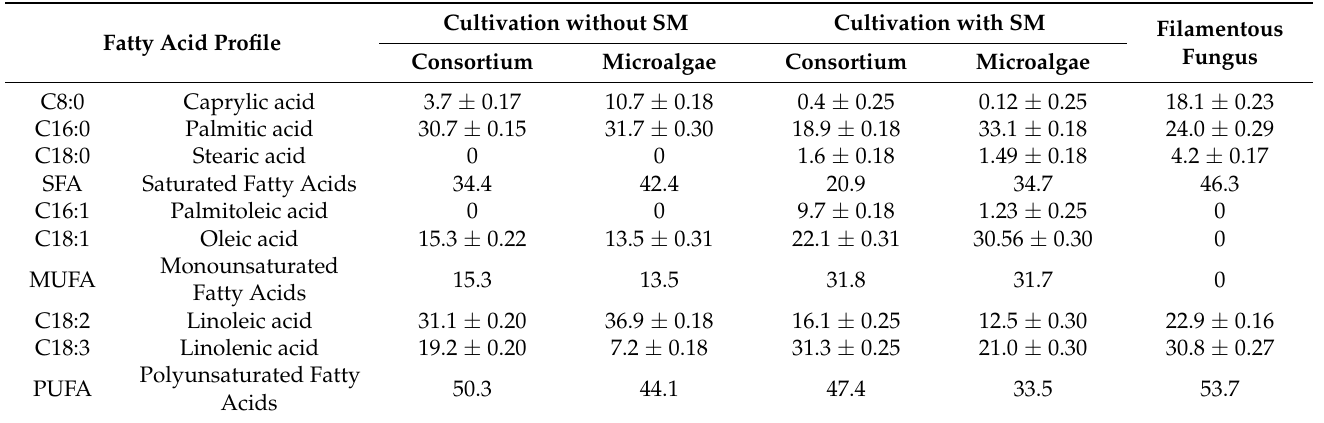
Table 2. Fatty acid composition of lipid material from the biomasses of microalgae ( S. obliquus ), fungus ( M. circinelloides) and lichens grown in an orbital shaker for 7.5